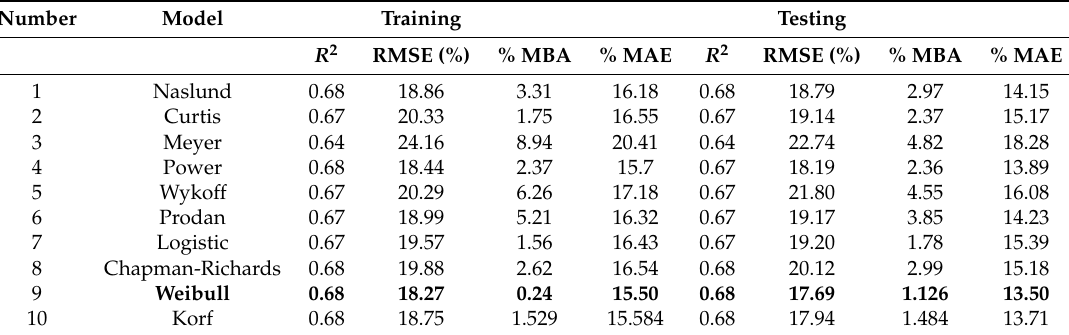
Table 6. Coefficient of determination, RMSE, and MAE for modeling and validation of 10 nonlinear models.